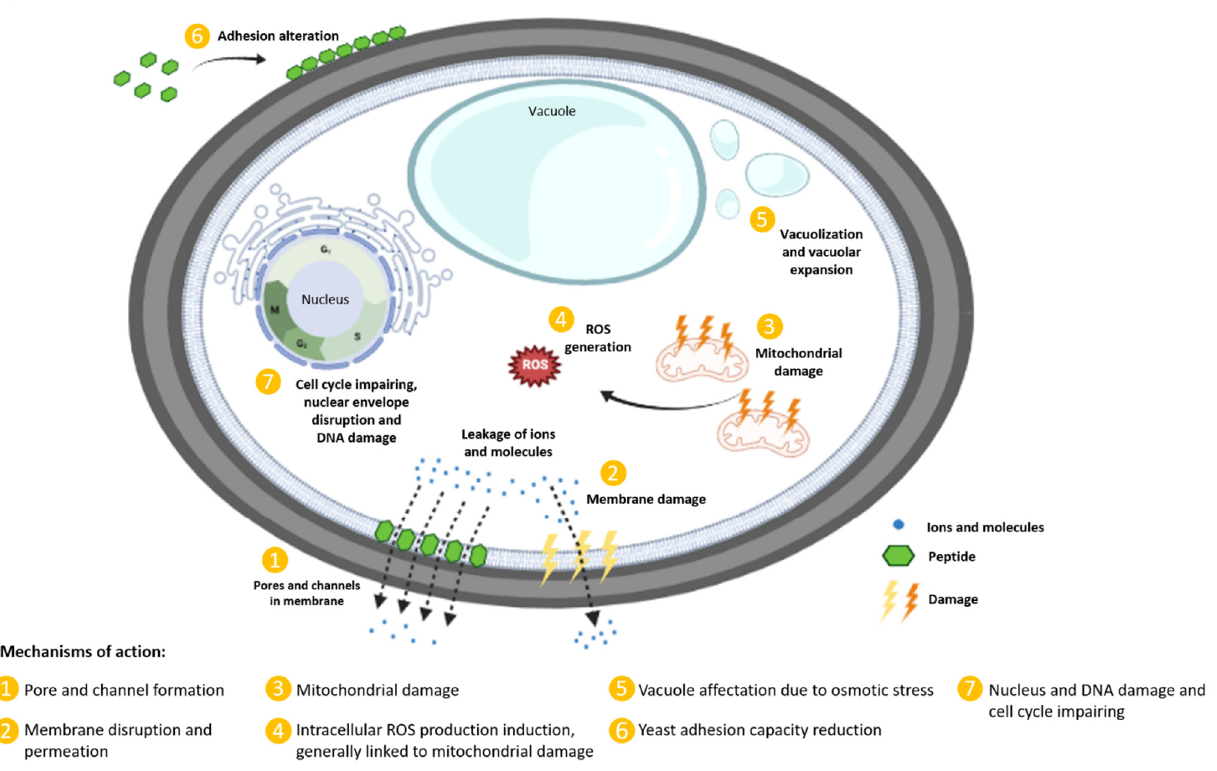
Figure 1. Schematic representation of the mechanisms of action of antimicrobial peptides for yeast.